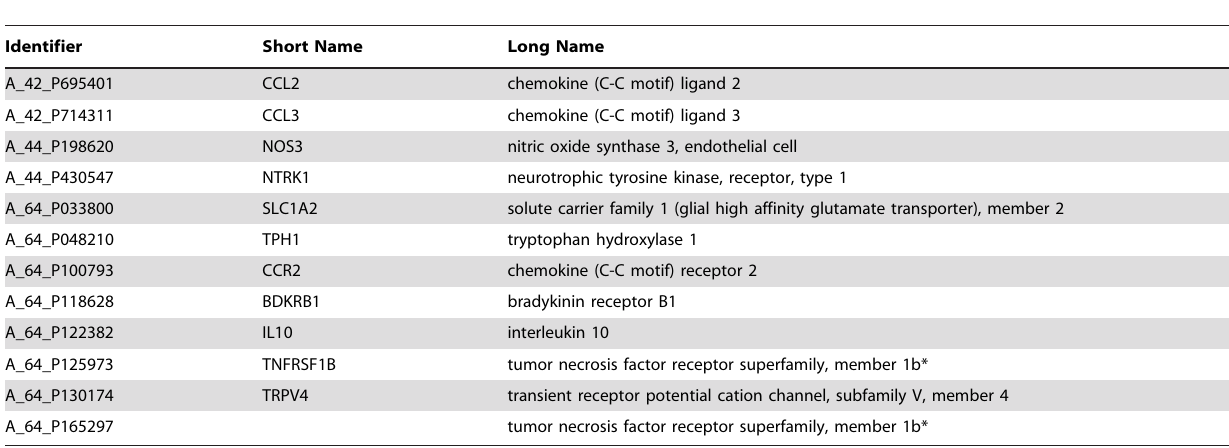
Table 7. Downregulated genes specifically involved in pain transmission in VSL # 3-treated NMS rats in comparison with not treated NMS